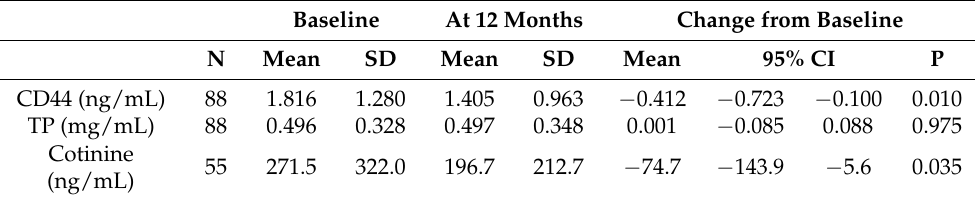
Table 2. Salivary biomarker levels at baseline and at 12 months following a smoking cessation program. Baseline At 12 Months Change from